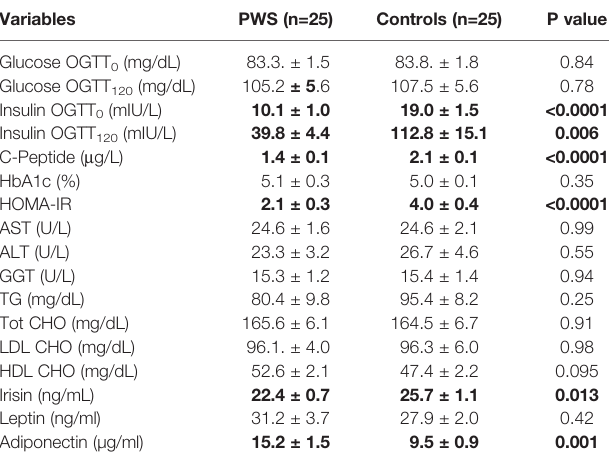
TABLE 2 | Summary of biochemical data obtained in PWS subjects and controls. Variables